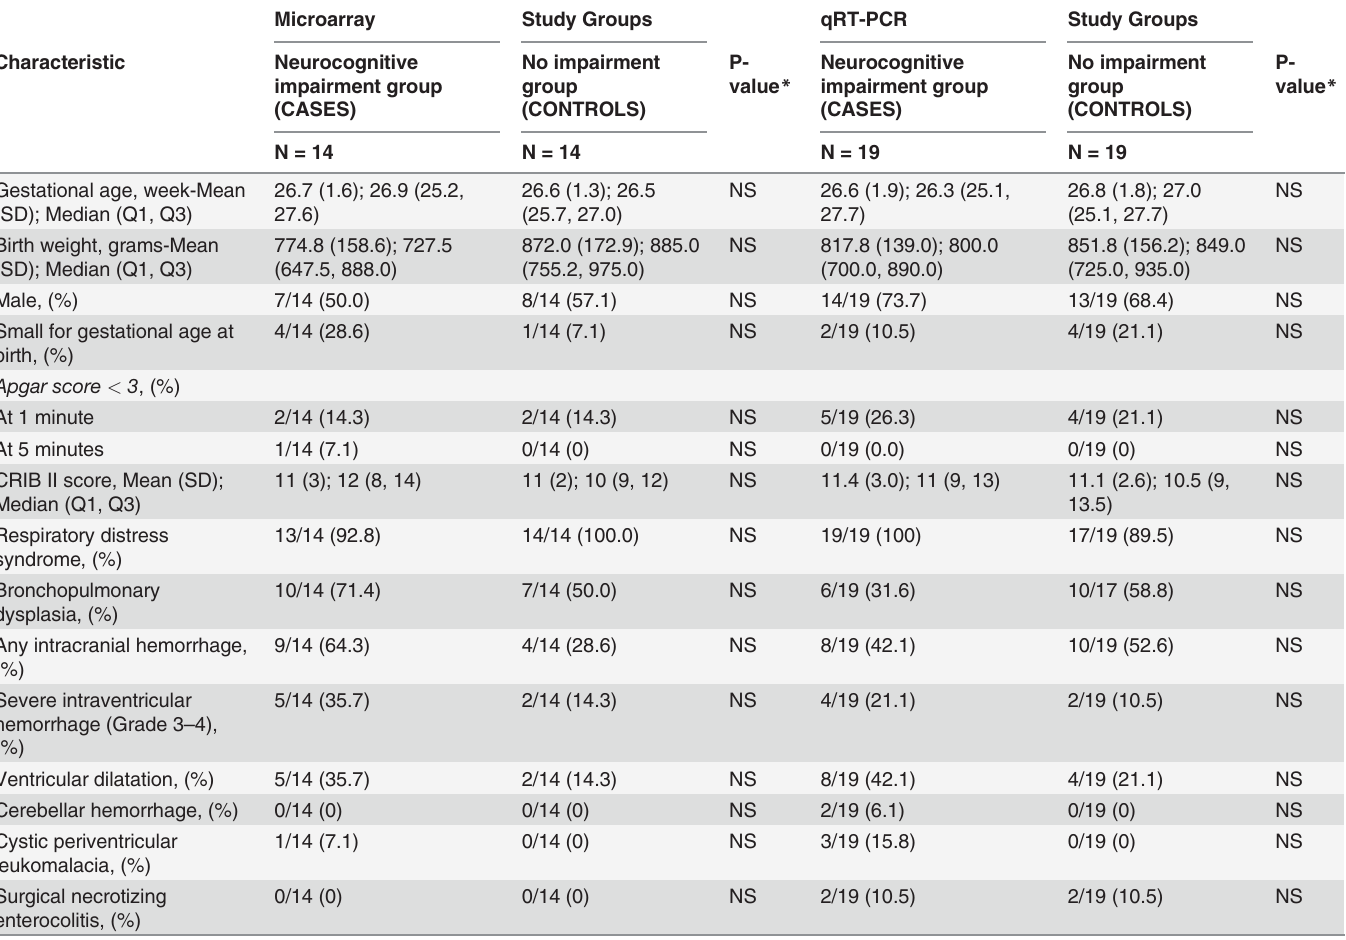
Table 2. Baseline neonatal characteristics of the two study groups.